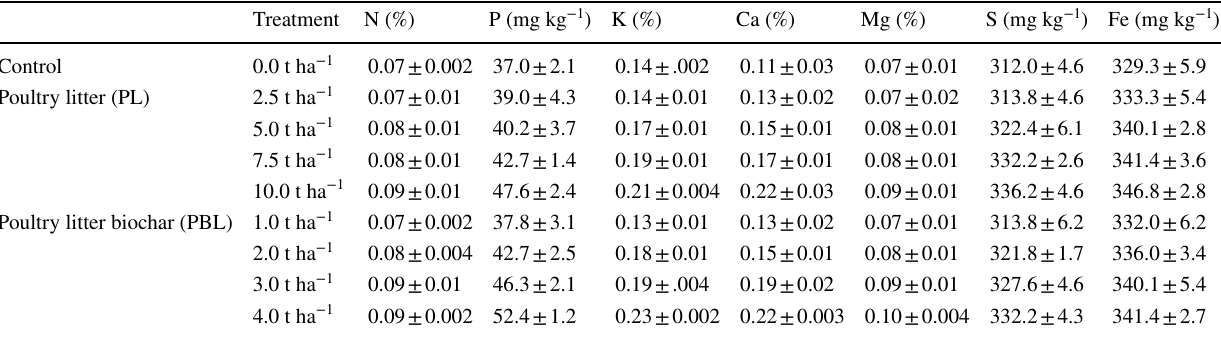
Table 5 Nutrient status of post-harvest soil